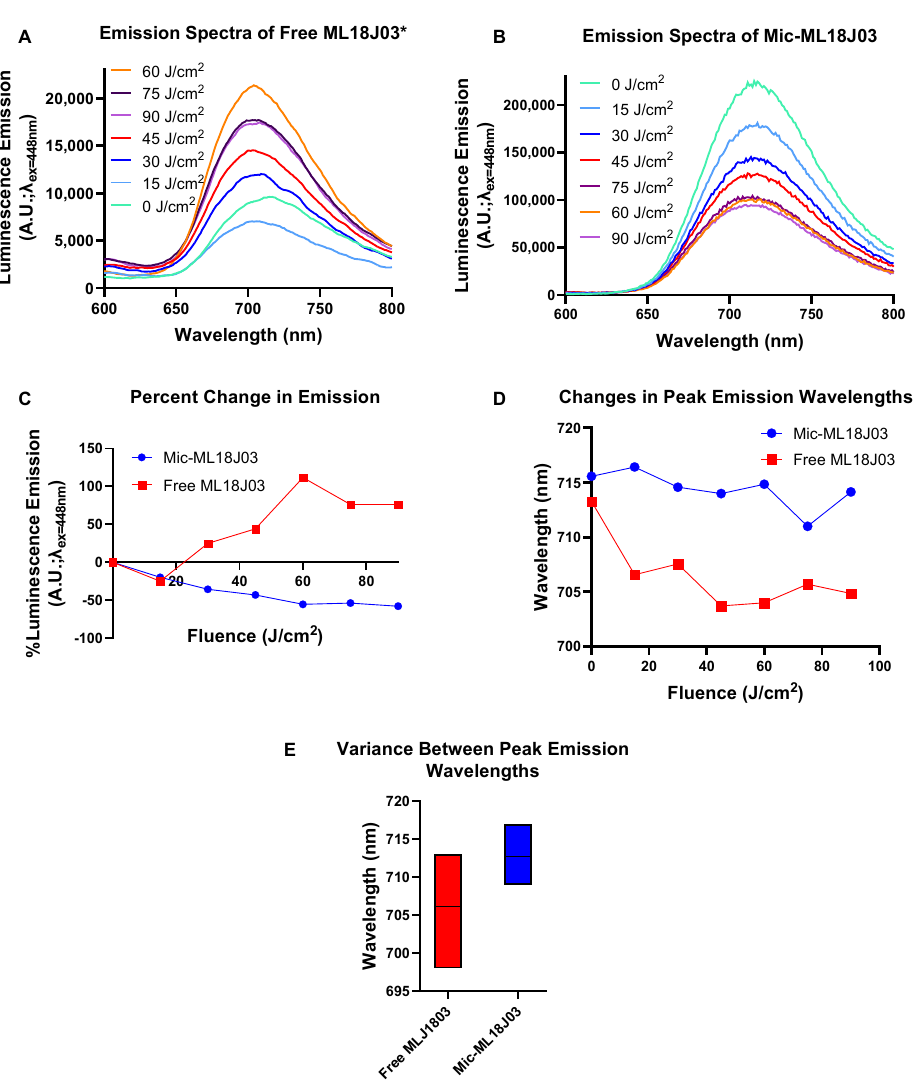
Figure 4. Raw luminescence emission spectra of free ML18J03 in 1% DMSO and PBS ( A ) and Mic- ML18J03 in PBS ( B ; λ Exc = 448 nm, λ Emi = 600–800 nm) upon photoirradiation using 420 nm light at an irradiance of 46.08 mW/cm 2 . ( C ) Relative changes in the peak luminescence emission values upon photoirradiation. ( D ) Shifts in the wavelengths of emission maxima of free ML18J03 and Mic- ML18J03 upon photoirradiation. ( E ) Min-max plot depicting the variations in peak luminescence emission wavelength for both free ML18J03 (variance = 27.26) and Mic-ML18J03 (variance = 6.48) during photoirradiation from 0–90 J/cm 2 . (Smoothing curve analysis applied with a factor of 10 to ( A